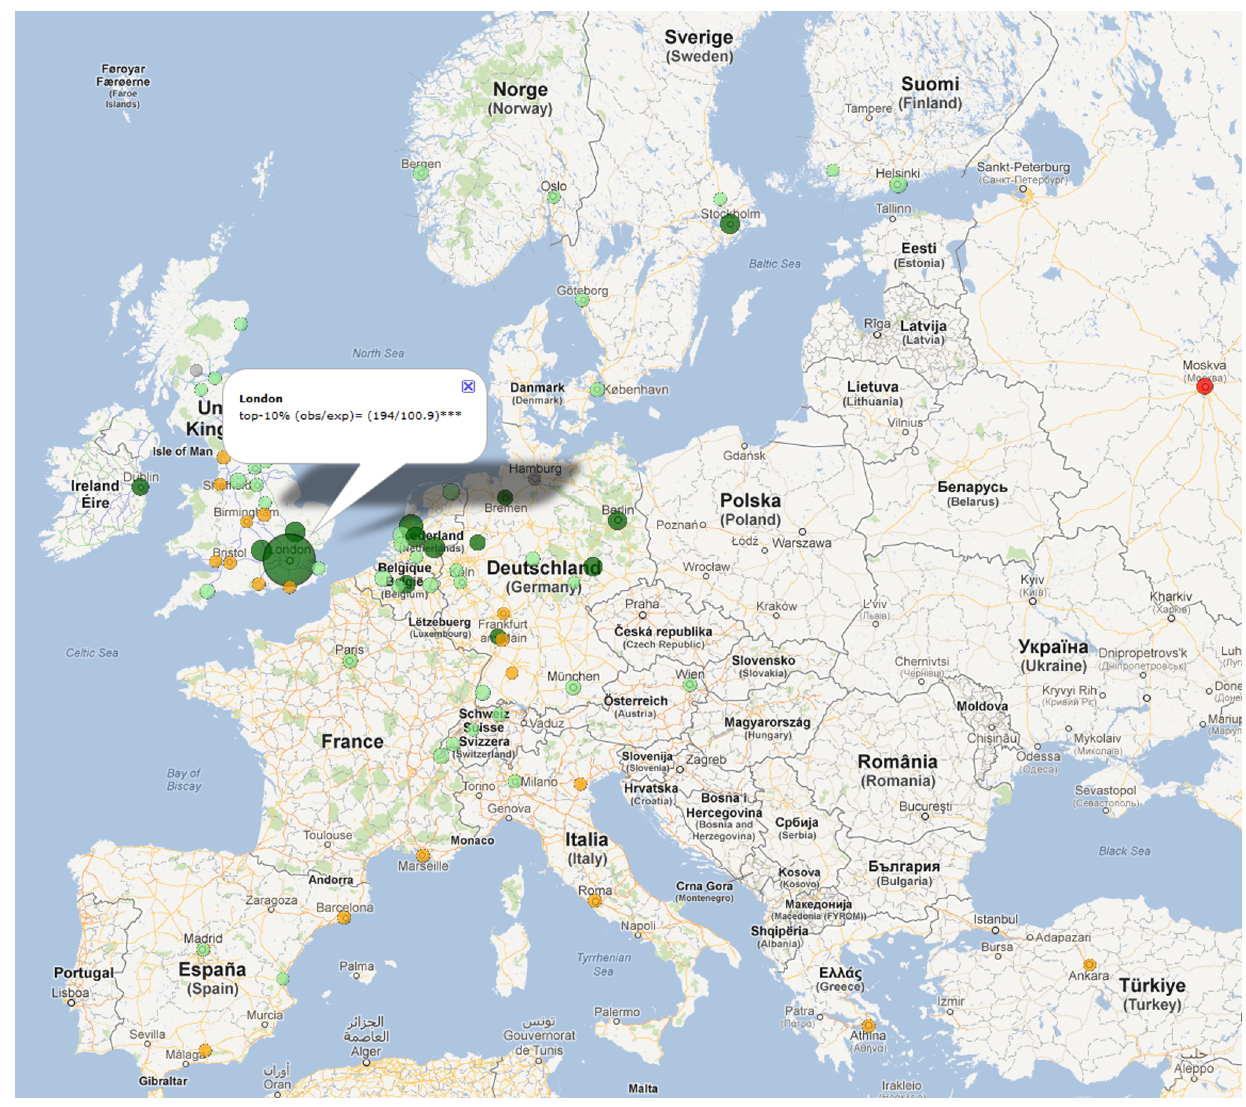
Figure 1. Cities in Europe with highly cited articles in psychology during 2007 (only cities are visualized with a total article output in 2007 of at least 50)